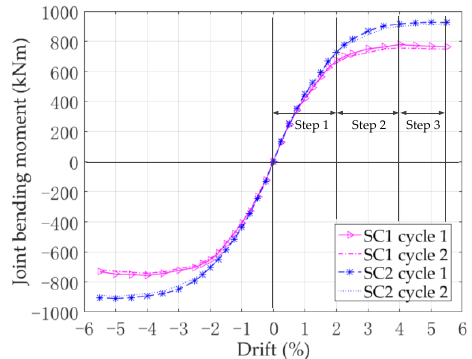
Figure 10. Comparison between the moment–drift envelope curves.